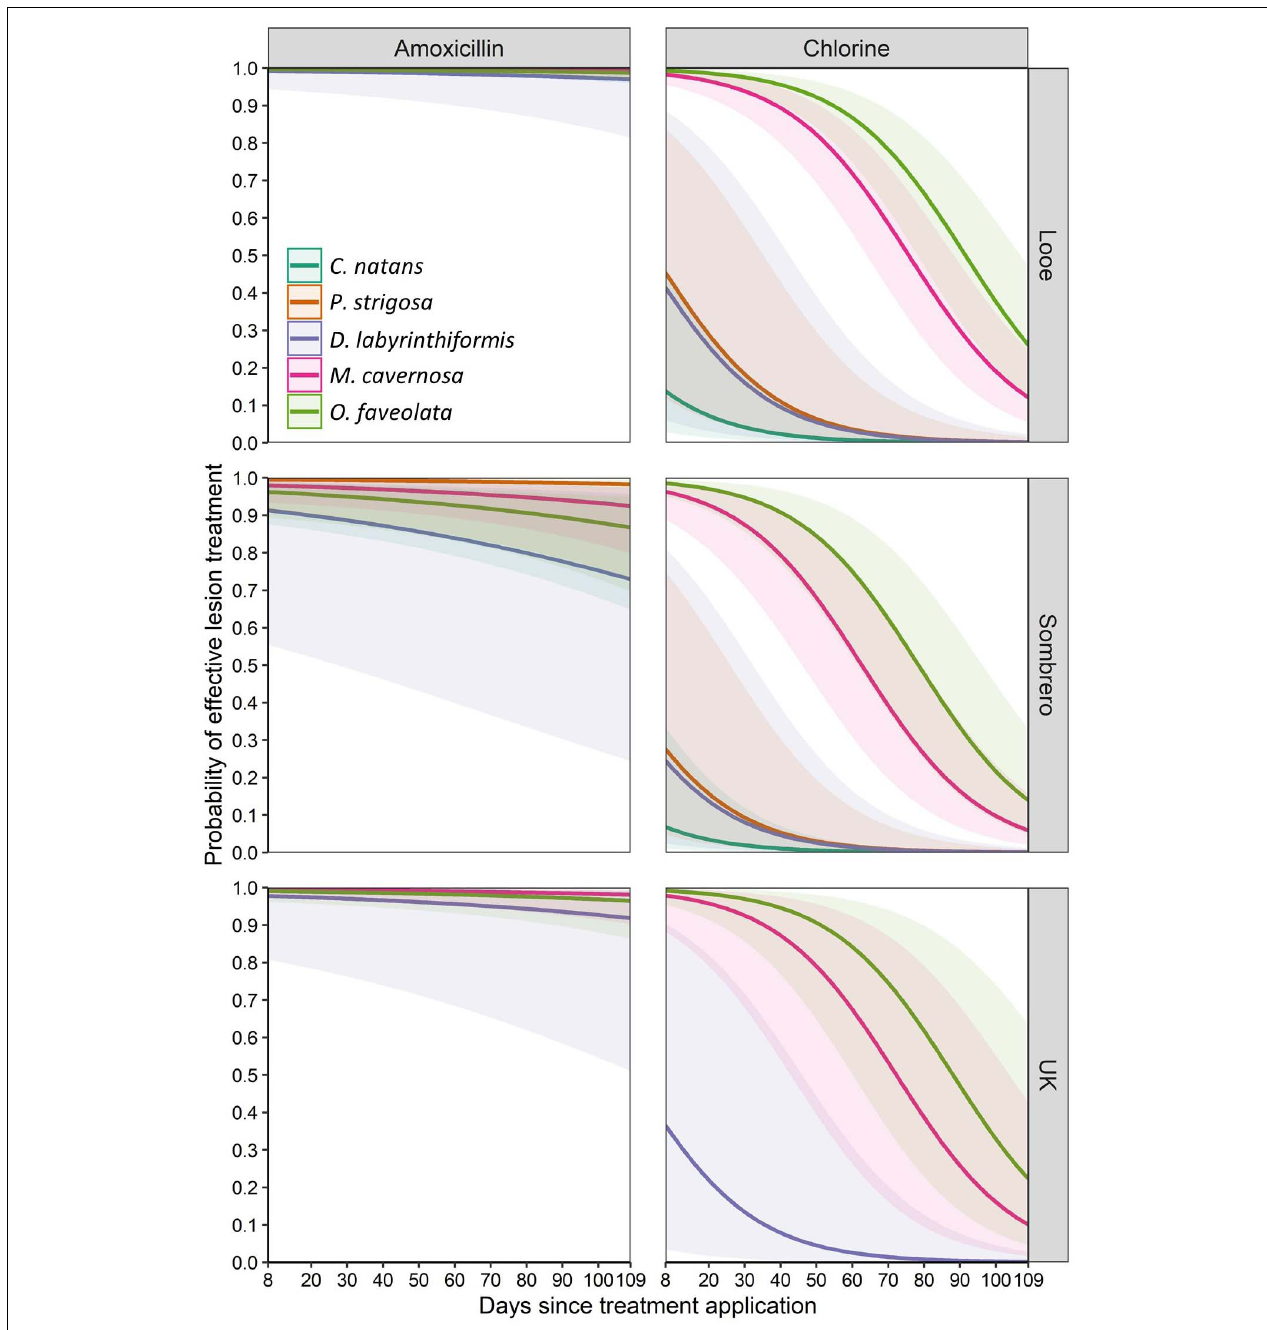
FIGURE 5 | Mean predicted probability (solid lines) of effective lesion treatment for three months after application. Amoxicillin and chlorinated epoxy effectiveness levels are shown for five species across three sites. Shaded areas represent 95% confidence intervals.